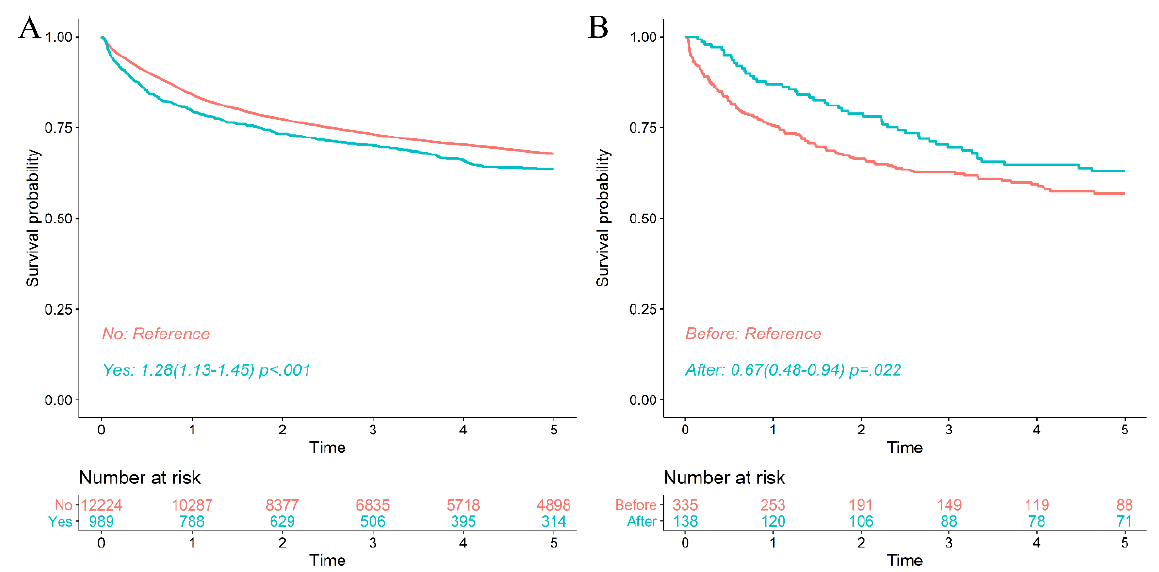
Figure 4. Poor prognosis when taking antivirals for chronic hepatitis B virus before a diagnosis of malignant lymphoma. ( A ). The survival rate of patients taking antiviral drugs before a diagnosis of malignant lymphoma was significantly lower than that of patients not taking antiviral drugs. (Patients who started antiviral drugs within the first 3 months before their diagnosis of malignant lymphoma were excluded). ( B ). The survival rate of cirrhotic patients taking antiviral drugs before their diagnosis of malignant lymphoma was significantly lower than that of patients not taking antiviral drugs. (After the diagnosis of malignant lymphoma, antiviral treatment was started. The patients who started antiviral drugs within 3 months before their diagnosis of malignant lymphoma were excluded).